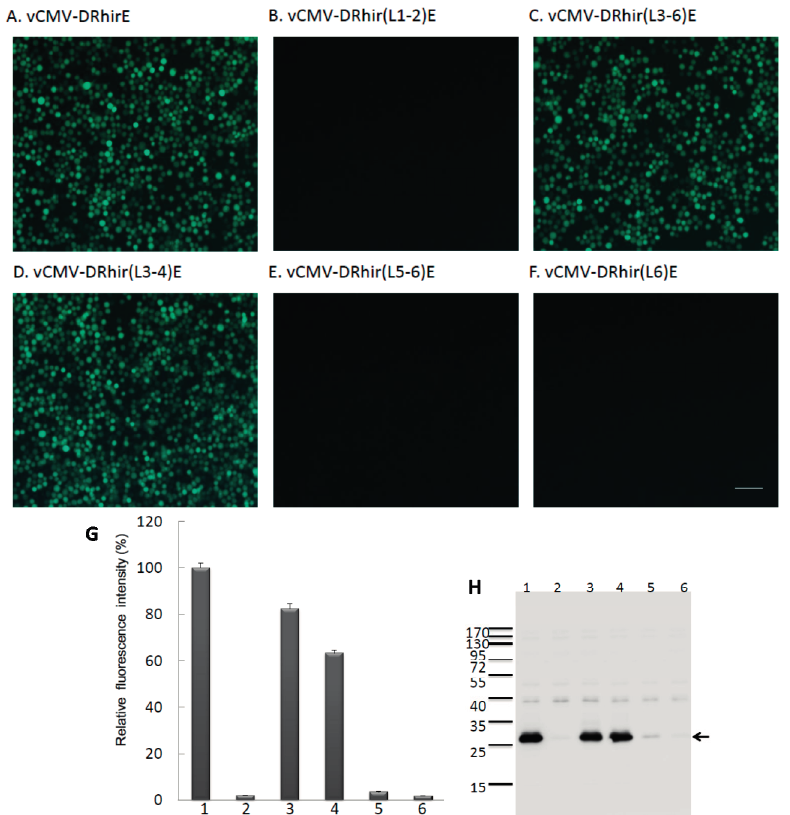
Figure 2. Identification of the TAAG motifs in the cDNA of RhPV 5 ′ IRES that are required for promoter activity in baculovirus infected Sf21 cells. Fluorescence micrographs of Sf21 cells infected with ( A ) vAcCMV-DRhirE (positive control); ( B ) vCMV-DRhir(L1-2)E; ( C ) vCMV-DRhir(L3-6)E; ( D ) vCMV-DRhir(L3-4)E; ( E ) vCMV-DRhir(L5-6)E or ( F ) vCMV-DRhir(L6)E at a multiplicity of infection of 1 at three days post-infection. Pictures were taken under a FITC channel with a 450/490-nm filter set using an exposure time of 900 ms; scale bar is 50 μ m; ( G , H ) Quantitative analysis of promoter activity in the different TAAG motifs truncated cDNA fragments of RhPV 5 ′ IRES by spectrofluorometer and Western blot; ( G ) Spectrofluorometric measurement of EGFP fluorescence in lysates (100 μ L; 50 μ g of protein) from Sf21 cells infected with (1) vAcCMV-DRhirE; (2) vCMV-DRhir(L1-2)E; (3) vCMV-DRhir(L3-6)E; (4) vCMV-DRhir(L3-4)E; (5) vCMV-DRhir(L5-6)E or (6) vAcCMV-DRhir423E. EGFP fluorescence emission was excited at 488 nm and monitored at 507 nm. The fluorescence intensity of EGFP was normalized to that of vAcCMV-DRhirE infected Sf21 cell lysates (100%); ( H ) Western blot analysis of cellular lysates from Sf21 cells infected with vAcCMV-DRhirE (Lane 1), vCMV-DRhir(L1-2)E (Lane 2), vCMV-DRhir(L3-6)E (Lane 3), vCMV-DRhir(L3-4)E (Lane 4), vCMV-DRhir(L5-6)E (Lane 5) or vCMV-DRhir(L6)E (Lane 6). Proteins (25 μ g per lane) were separated by 12% SDS–PAGE and then electrotransferred onto PVDF membranes, which were then incubated with rabbit anti-GFP polyclonal antibody followed by an HRP-conjugated goat anti-rabbit secondary antibody. Detected protein bands were visualized on X-ray film using a Western blot chemiluminescence kit. Molecular mass markers (kDa) are indicated at left and the arrow indicated the EGFP protein